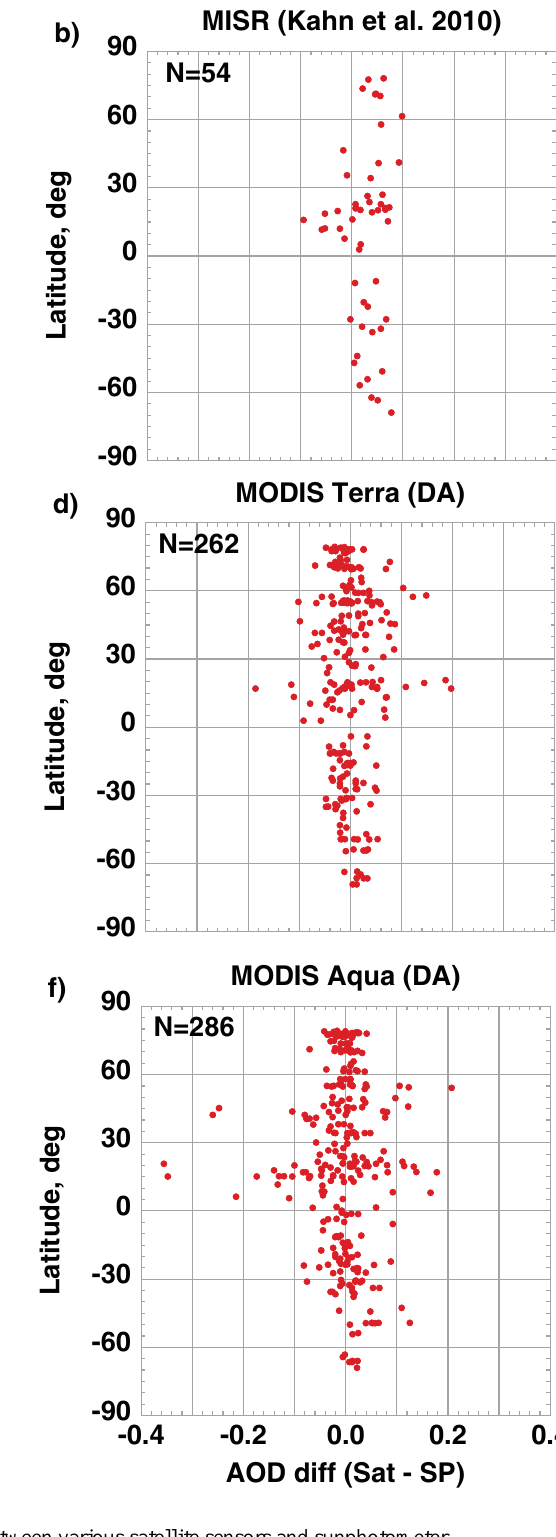
Fig. 9. Latitudinal dependence of aerosol optical depth differences between various satellite sensors and sunphotometer.